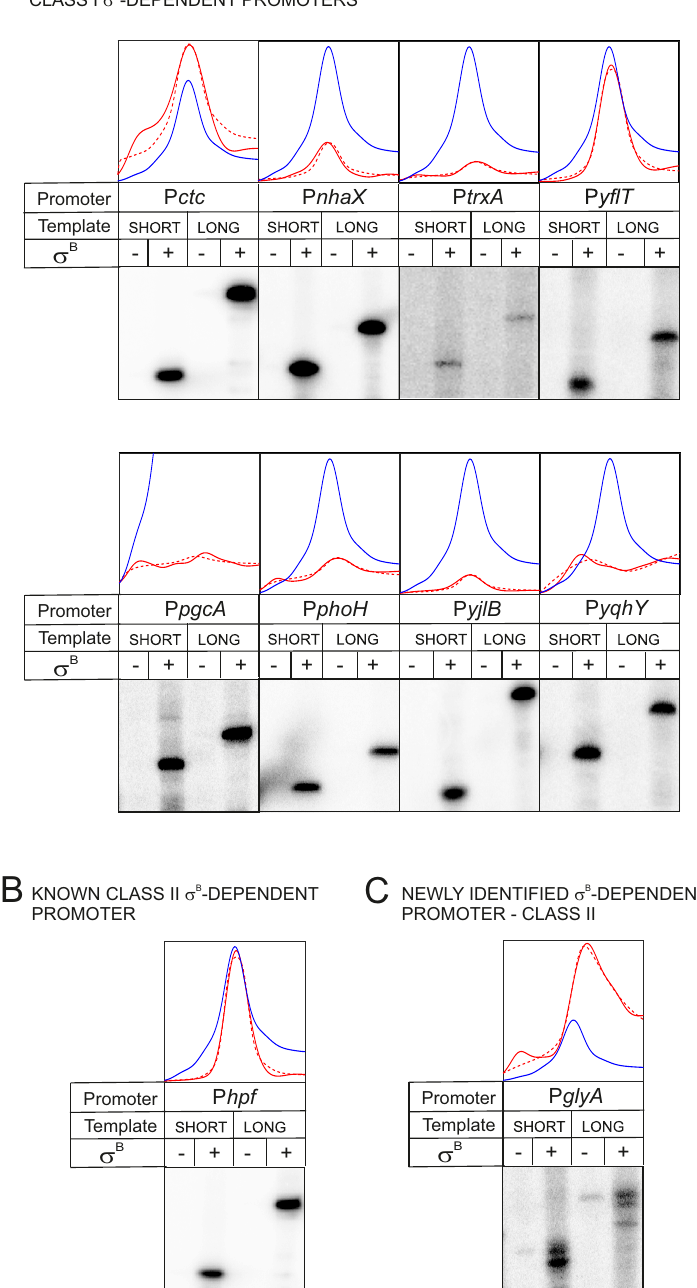
Figure 3. Experimental verification of SigB dependence of selected promoters. The validation was done by in vitro transcription with B. subtilis RNAP complexed with SigB ( σ B). ( A )–Class I promoters [contain canonically spaced (by 13–15 bp) − 35 and − 10 elements]. ( B )–A known Class II promoter contains only the − 10 element, highly resembling the consensus sequence. ( C )–genes of the Class II promoter. Curves represent modeled (red dashed line) and experimental (red solid line) expression profiles of the given gene; blue line is the expression profile of SigB. SHORT and LONG refer to template length (two sizes for each promoter region) to distinguish the orientation of the promoter within the template. − /+ indicate the absence/presence of SigB. In the absence of SigB, only the RNAP core was used. trxA was used as a